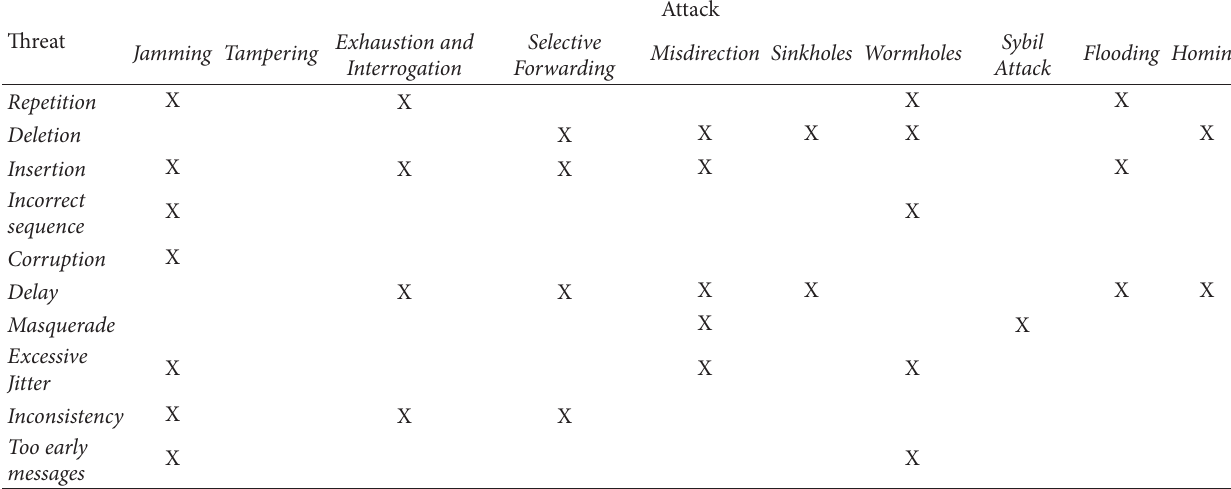
Table 3: Connection table between WSN attacks taxonomy and EN50159